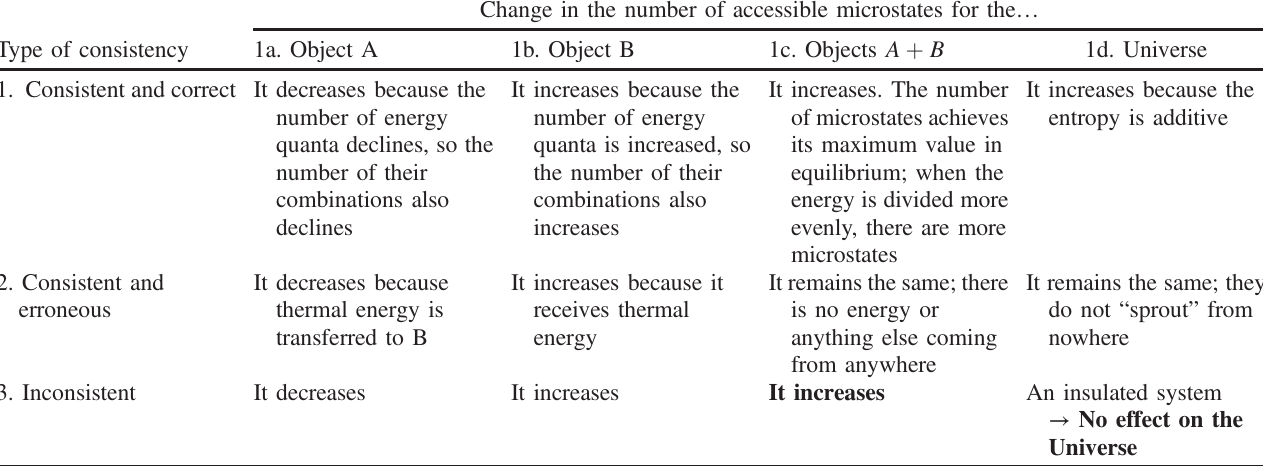
TABLE IV. Sample quotes from different types of answers in terms of consistency in items 2a – 2d, which were concerned with changes in the number of accessible microstates. Two types (correct and erroneous) of consistent sets of answers and one set of inconsistent answers are shown. The inconsistency is in boldface in the final sample. Change in the number of accessible microstates for the